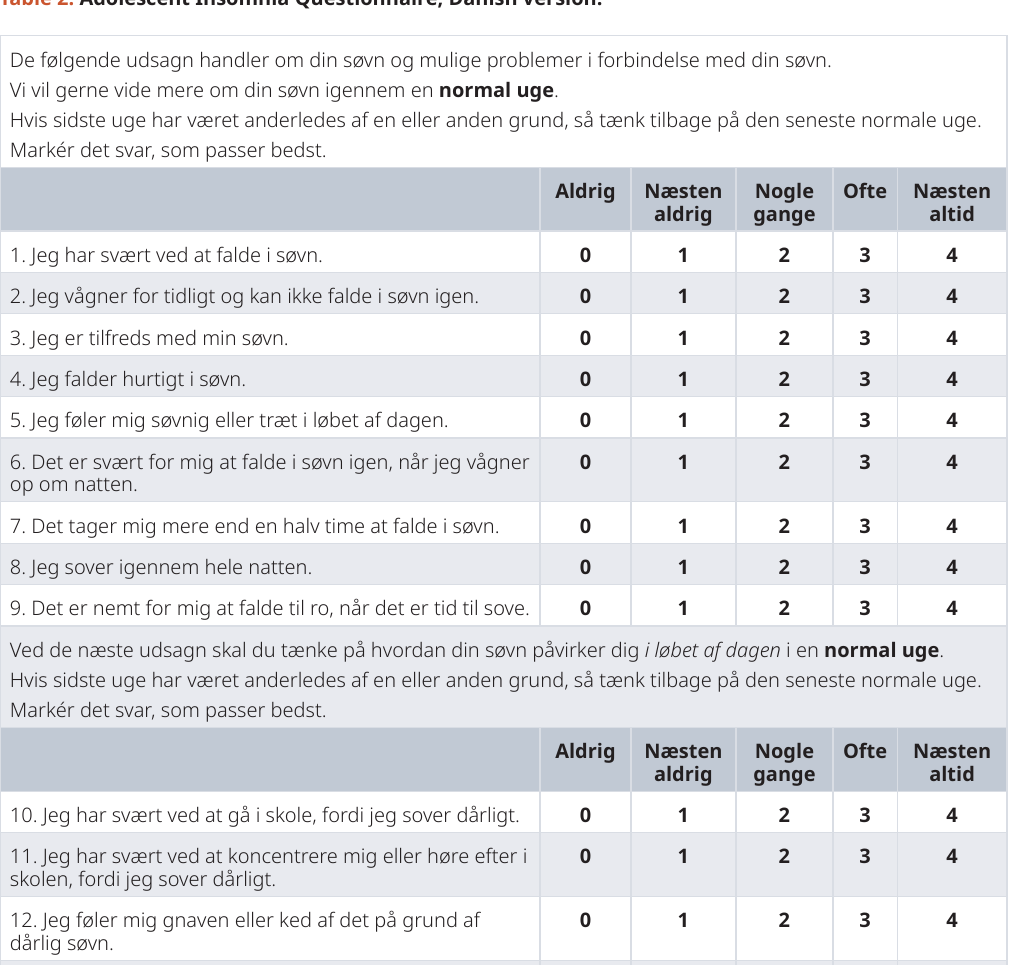
Table 2. Adolescent Insomnia Questionnaire, Danish version.